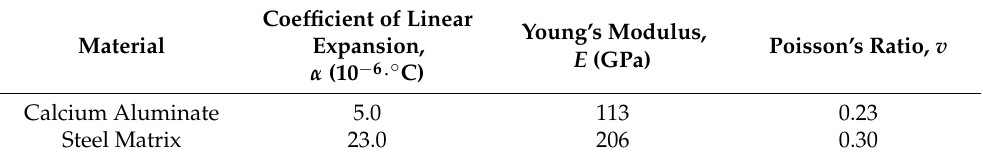
Table 2. Mechanical properties and thermal expansion coefficients [25,26].